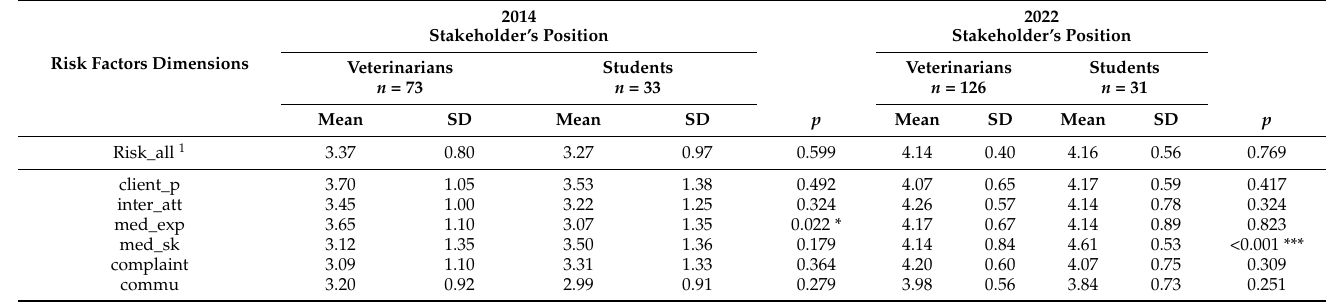
Table 5. The risk factor perception differences between veterinarians and students in 2014 and